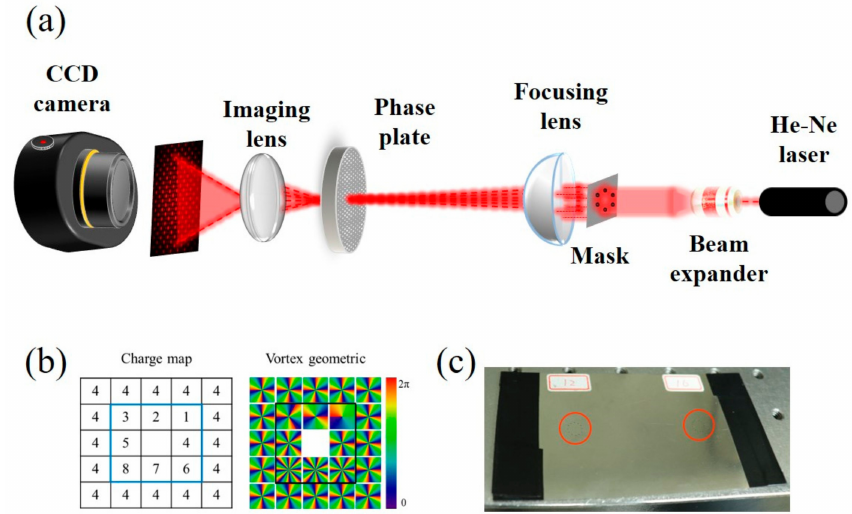
Figure 2. ( a ) Experimental setup for generating crystalline and kaleidoscope light beams with vortex– lattice structures. ( b ) The charge map and corresponding vortex geometry of the spiral phase plate. ( c ) The photo of steel mask for Q = 12 and Q =